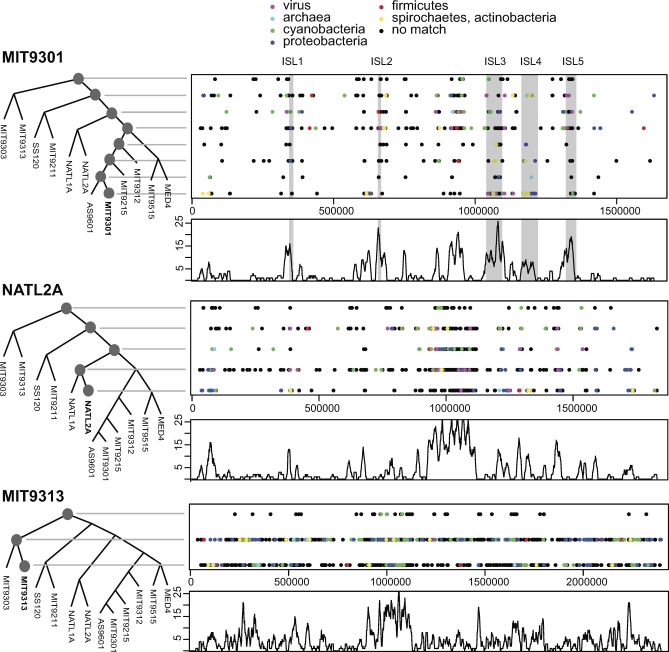
Gene Acquisitions Confirm Known, and Identify Novel, Genomic Islands in Prochlorococcus
The dot plots indicate the location on the chromosome and the ancestor node in which the gene is estimated to be gained. The color indicates where the best match was found. In MIT9301, The shaded regions are islands as defined by [60]. Gained genes are defined for each node as in Figure 3. The lower plot is the number of genes gained in a sliding window (size 10,000 bp, interval 1,000 bp) along the chromosome.